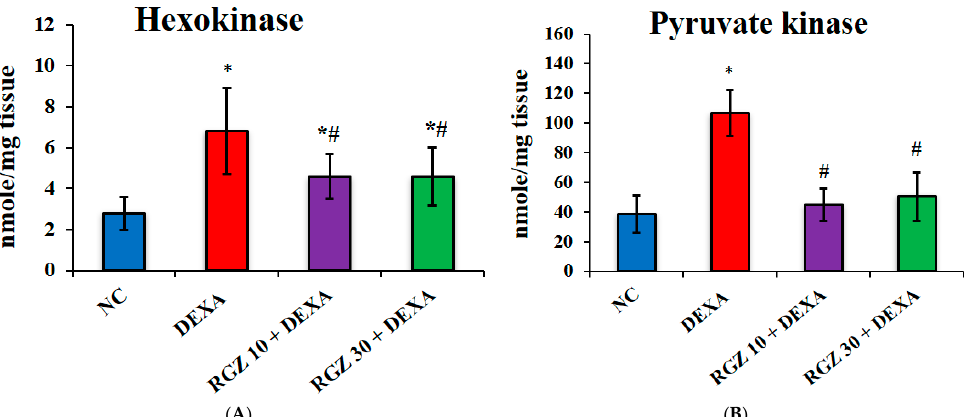
Figure 3. Effect of administration of DEXA, 20 mg/kg; s.c., RGZ, 10 mg/kg or 30 mg/kg, p.o., on cerebral hexokinase ( A ) and pyruvate kinase ( B ) in mice. The statistical evaluation was conducted by a one-way ANOVA and then Tukey’s post hoc test. Values are represented by the mean ± SD ( n = 8). NC—normal control; DEXA—dexamethasone; RGZ—rosiglitazone. A significant difference was considered at p < 0.05 and distinguished by * vs. NC; # vs. DEXA.